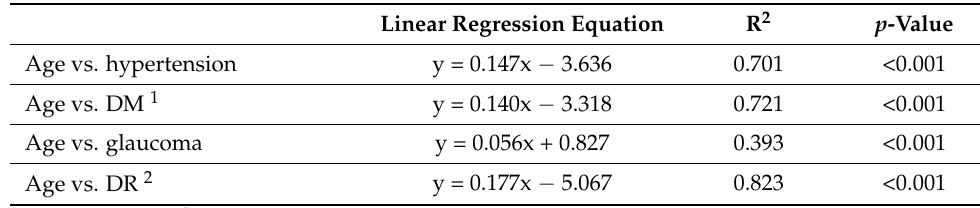
Table 5. Linear regression equation between age and the frequency of diseases.